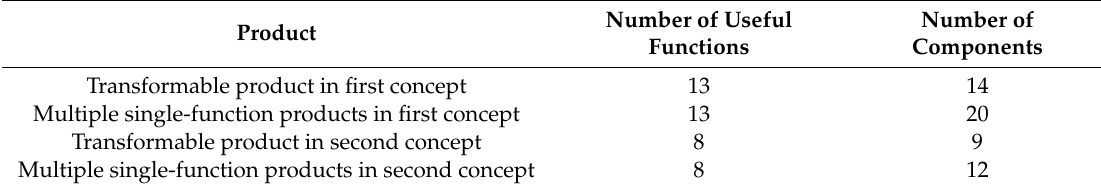
Figure 15. The second design of the wheelchair. ( a ) in toilet state, ( b ) in bathing state. Table 9. Useful functions and related components in two